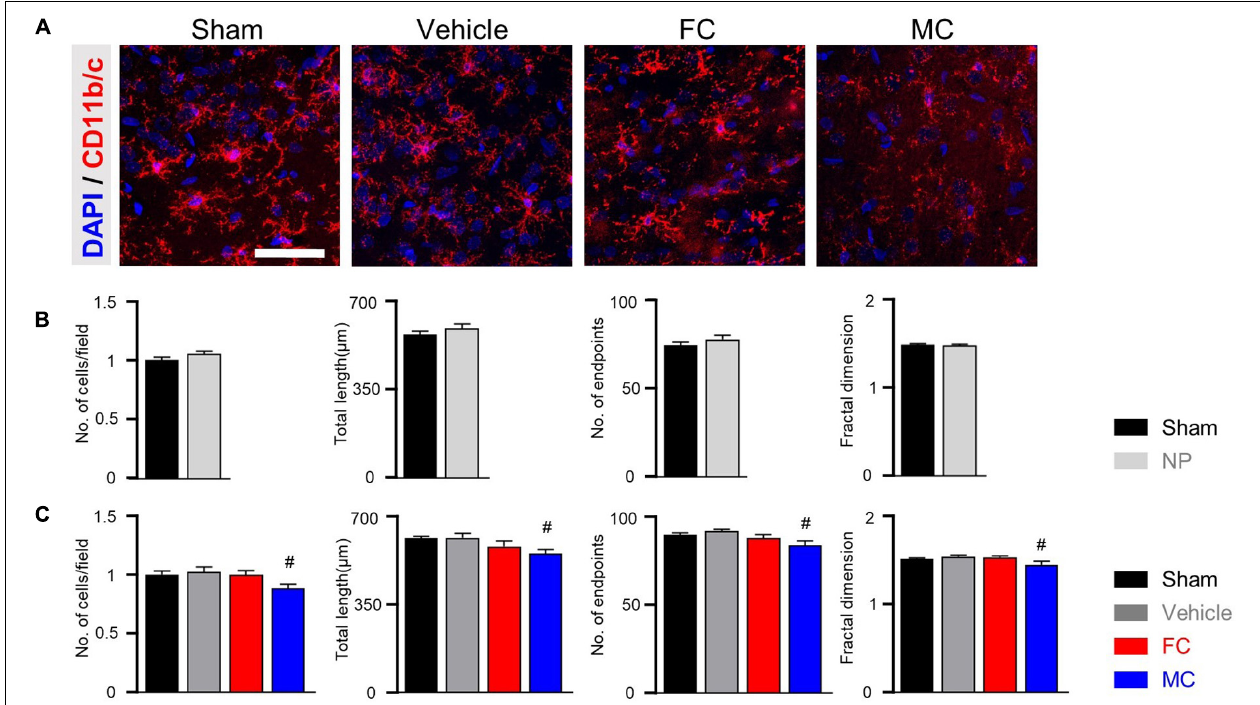
FIGURE 6 | Morphometric difference in microglia after late inhibition. (A) Representative images of CD11b/c-positive microglia in the IC on PID 14. In the comparison of morphological changes in microglia, no difference was found except in the MC group. Scale bar, 50 µ m. (B) Morphological complexity of microglia on PID 7. On PID 7, after late inhibition, there were no statistical differences in morphological properties among the groups (sham and NP; each group n = 4). (C) MC inhibited the morphological activation of microglia on PID 14. Total length, number of end points, and fractal dimension were quantified by skeleton analysis and fractal analysis (sham, vehicle, FC, and MC; each group n = 4). Scale bar, 50 µ m, and error bars are SEM. # p < 0.05 vs. vehicle, unpaired t -test for post hoc comparison and one-way ANOVA followed by Tukey’s post hoc multiple comparison